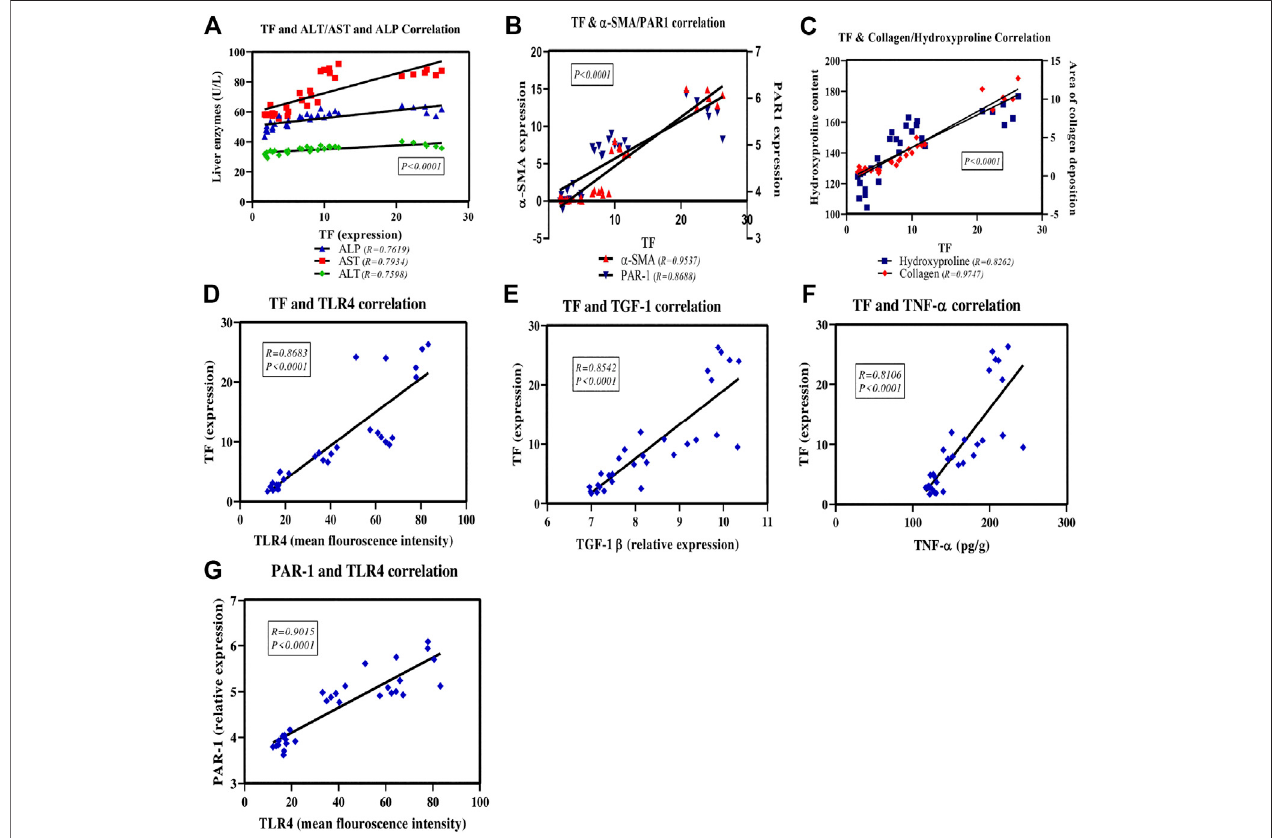
FIGURE 9 | Scatter plots of the correlation between TF and the assessed liver enzymes activities, in fl ammatory and fi brotic markers as well as between PAR1 and TLR4 expression. The solid lines represent the linear regression and correlation coef fi cient (r), P is the correlation signi fi cance level.